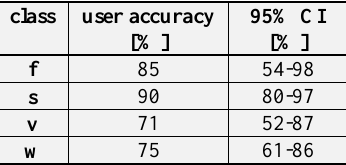
Table 2. User accuracy for each class (f=window, s=stonework, v=vegetation, w=painted